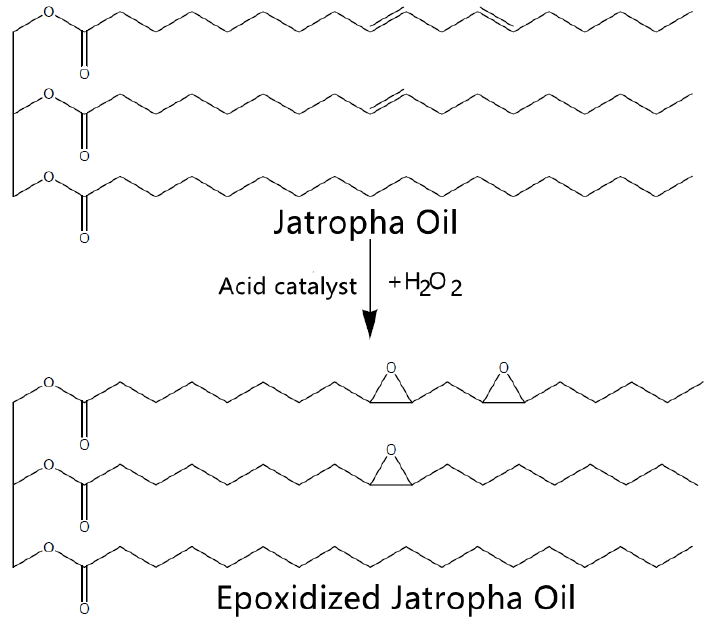
Figure 4. Epoxidation of Jatropha oil. Reprinted with permission from Ref. [36]. Copyright 2017 MDPI.